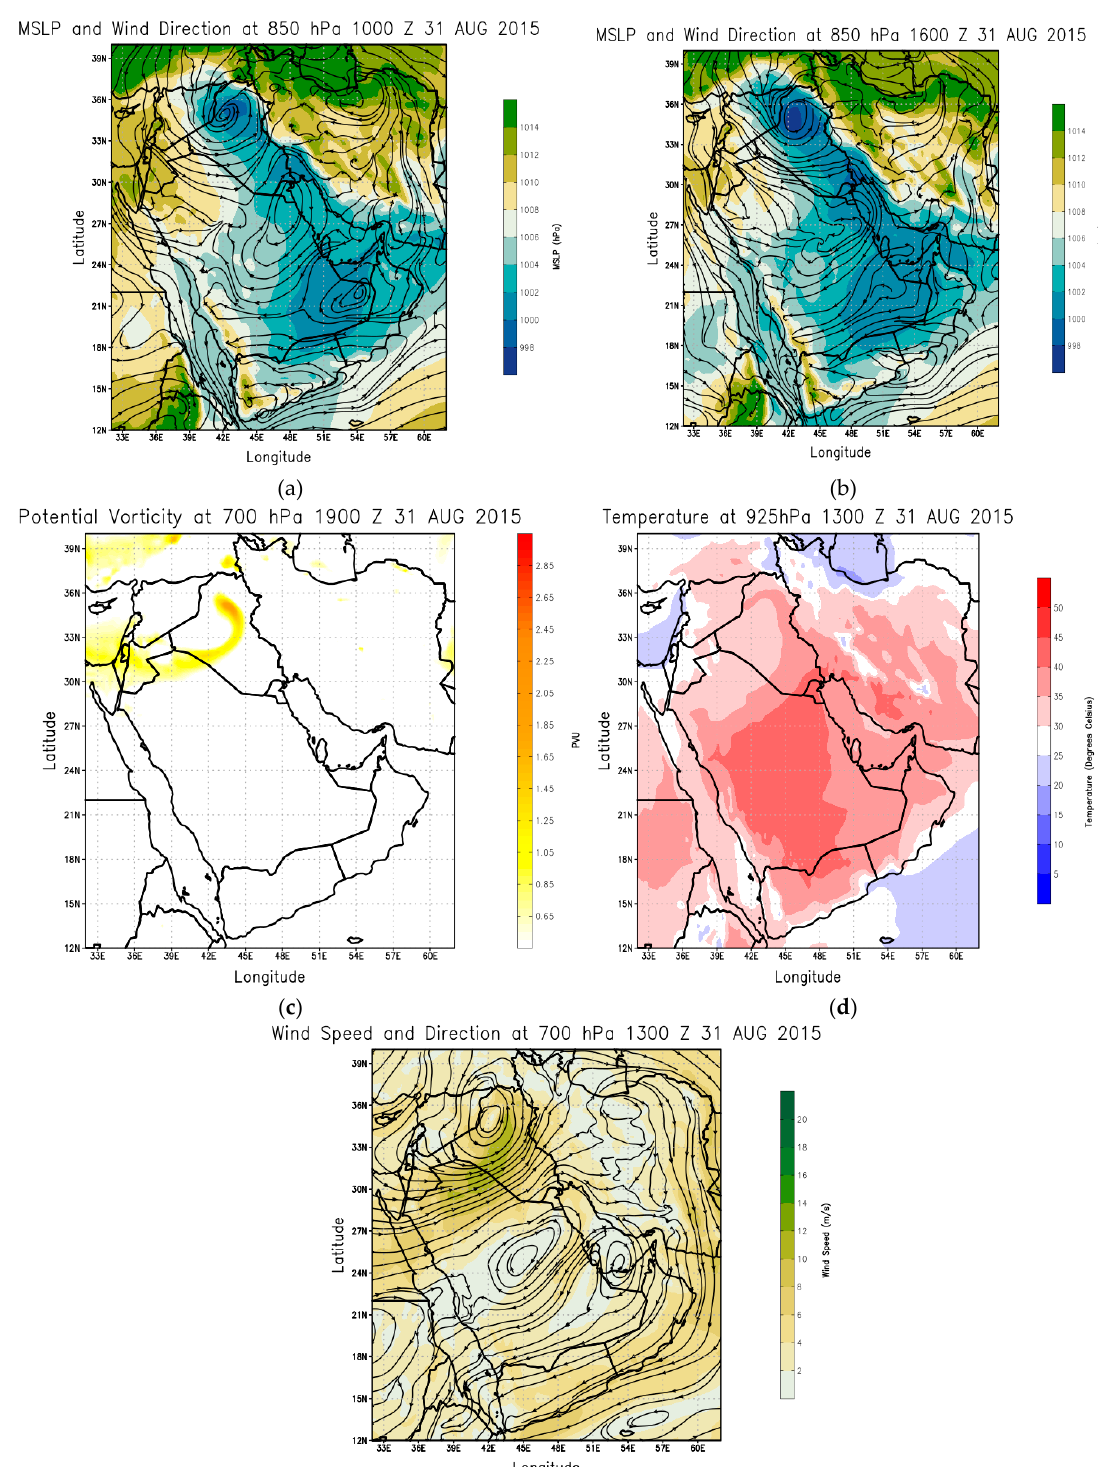
Figure 3. ECMWF ERA5 re-analyses on 31 August 2015 of: ( a ) Mean sea level pressure (colors) and wind direction at 850 hPa at 1000UTC and at 1600UTC ( b ). ( c ) Potential vorticity at 700 hPa at 1900UTC. ( d ) Temperature at 925 hPa at 1300UTC. ( e ) Wind speed (colors) and wind direction (streamlines) at 700 hPa at 1300UTC.